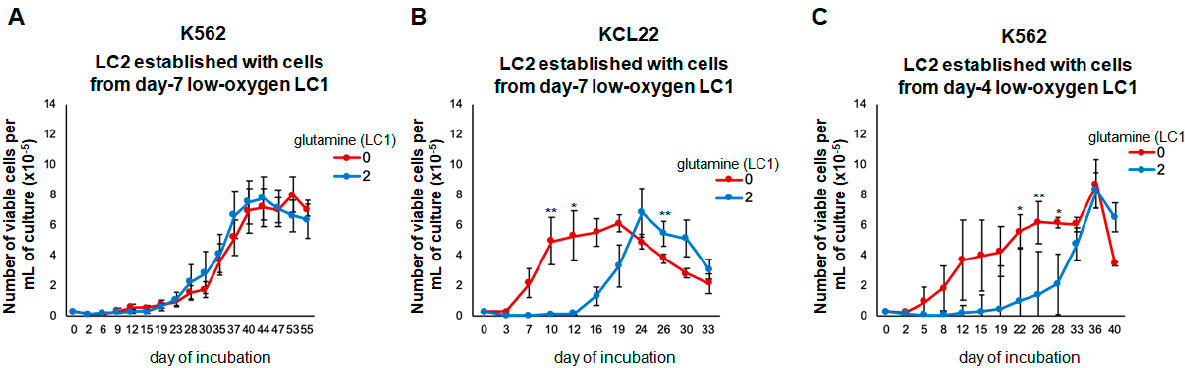
Figure 3. Effects of the lack of glutamine on the maintenance of stem cell potential in low oxygen. K562 ( A , C ) or KCL22 ( B ) cells were seeded at 3 × 10 5 cells/mL and incubated in atmosphere at 0.2% O 2 in the absence (0) or the presence (2) of 2 mM glutamine from time 0 of incubation (LC1). Cells were rescued from LC1 on day 7 ( A , B ) or 4 ( C ) and replated at 3 × 10 4 cells/mL in growth-permissive, “expansion” secondary cultures (LC2) incubated at 21% O 2 and in any case in the presence of glutamine. Trypan blue-negative cells were counted at the times of incubation in LC2 indicated in abscissa. Values are mean ± S.D. of data obtained from 3 independent experiments; 0 vs. 2 mM glutamine: * p < 0.05, ** p < 0.01.